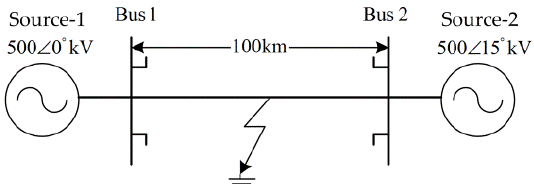
Figure 1. Diagram of the simplified transmission line model.